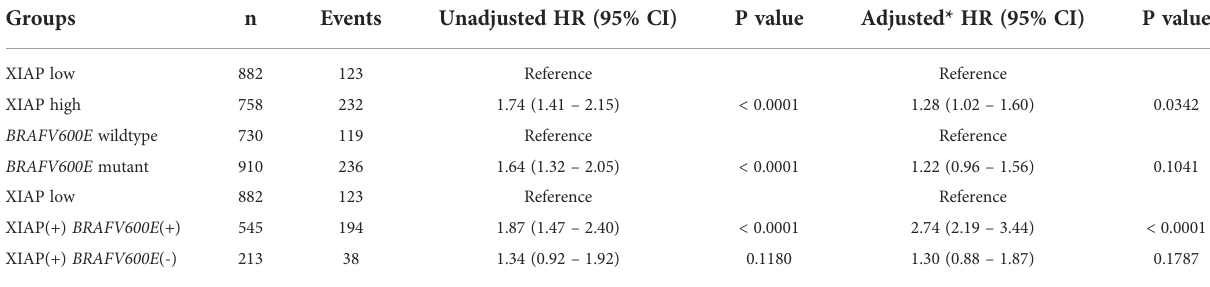
TABLE 4 Comparison of multivariate analysis to predict DFS using the XIAP status alone or in combination with BRAFV600E mutation. Groups